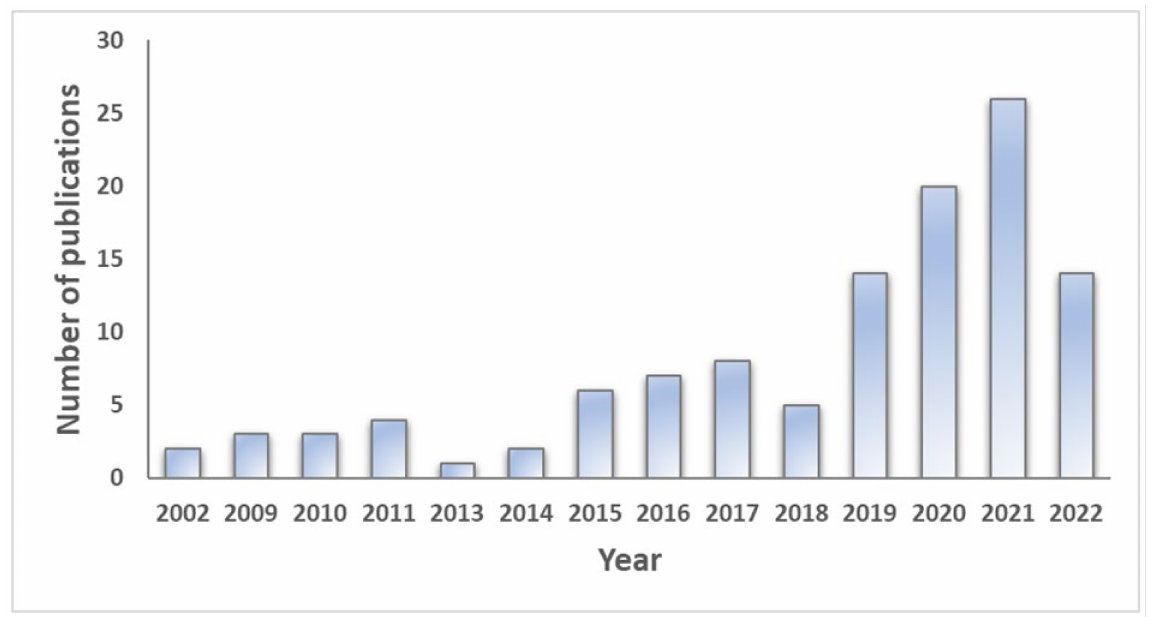
Figure 4. Number of published articles on transcriptomics in maize from 2002 to 2022. A web-search query through Google Scholar was used for a meta-analysis of 187 relevant articles. A keyword search was conducted in the abstract of the transcriptomics studies. Source: Google Scholar, dated 5 May